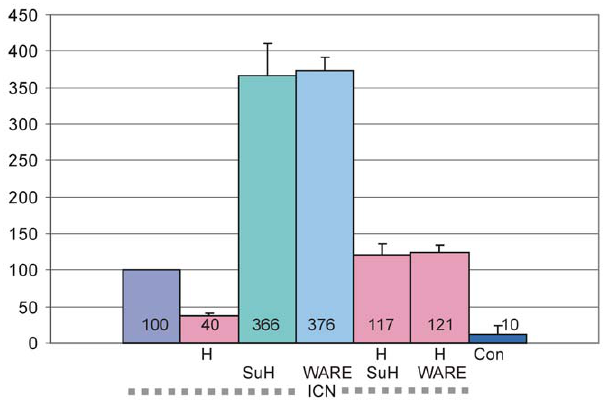
Figure 4. Activation and repression of a Notch reporter gene by Su(H) variants. Effects of the mutant Su(H) WARE (WARE) on Notch ICN mediated expression from the NRE-reporter (luciferase reporter containing wild type Su(H) binding sites, [13]) were analysed in Drosophila S2 cell culture. Indicated constructs, Notch ICN, full length Hairless (H), full length Suppressor of Hairless (SuH) or the mutant Su(H) WARE (WARE) were used to transiently transfect S2 cells; empty vector served as a negative control (Con). Luciferase activity